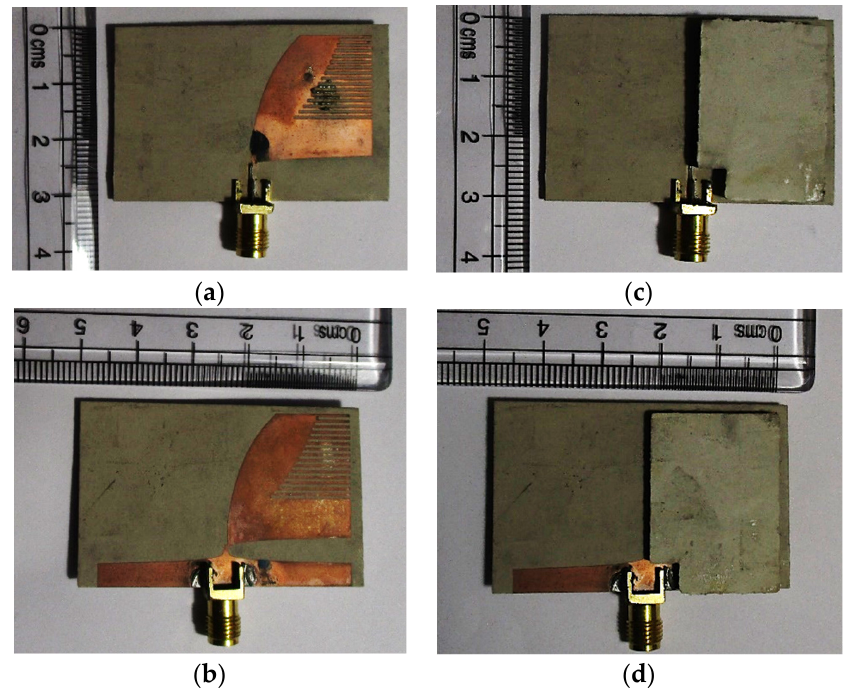
Figure 9. Fabricated prototype of the proposed antenna 1: ( a ) top layer without the superstrate, ( b ) bottom layer without the superstrate, ( c ) top layer with the superstrate, ( d ) bottom layer with the superstrate.